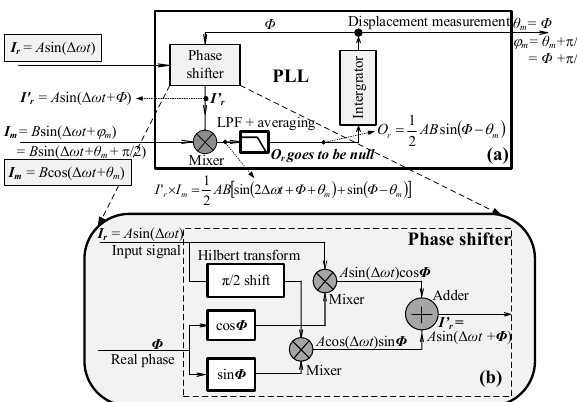
Figure 2. Schematic diagram of the phase meter using two sinusoidal heterodyne signals: (a) whole system and (b) phase shifter. PLL, phase-locked loop, LPF + averaging, low-pass filter combined with an averaging operation.